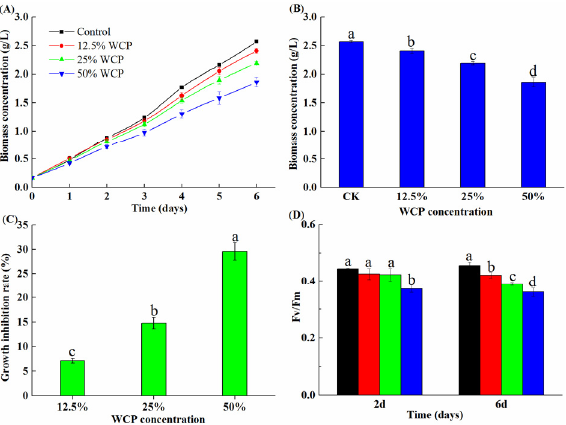
Figure 2. Effects of different caprolactam wastewater concentrations on the growth and maximum quantum yield (Fv/Fm) of Arthrospira platensis . ( A ) Growth curves of A. platensis , ( B ) final biomass concentration, ( C ) growth inhibition rate (%), and ( D ) Fv/Fm. Error bars represent the standard deviation ( n = 3). Data with different letters indicate significant differences ( p < 0.05) between the control and treatments.